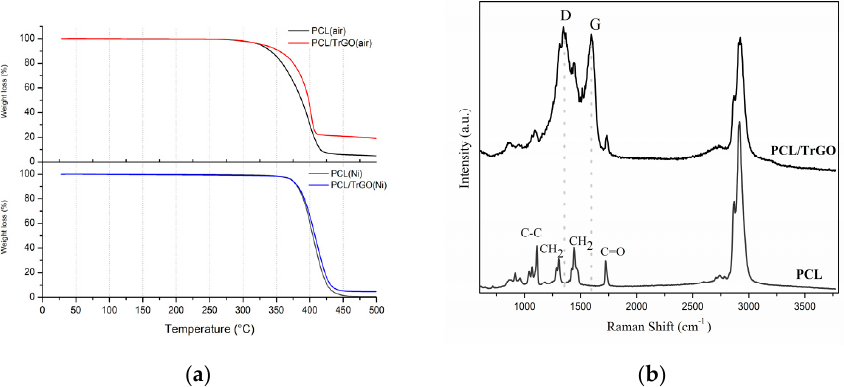
Figure 3. ( a ) Thermogravimetric analysis (TGA) curves in air and nitrogen atmosphere; ( b ) Raman spectra of PCL / TrGO composite and PCL